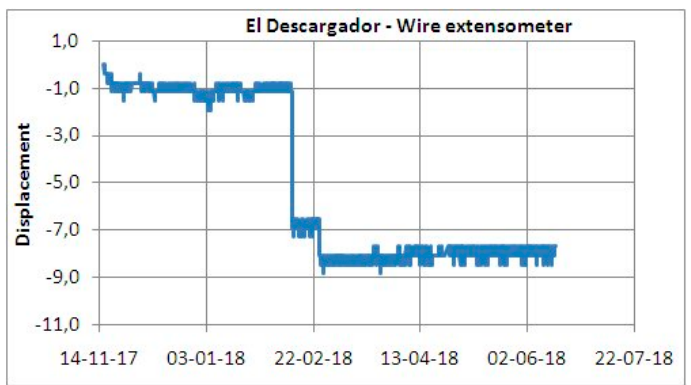
Figure 3. Wire extensometer placed on El Descargador